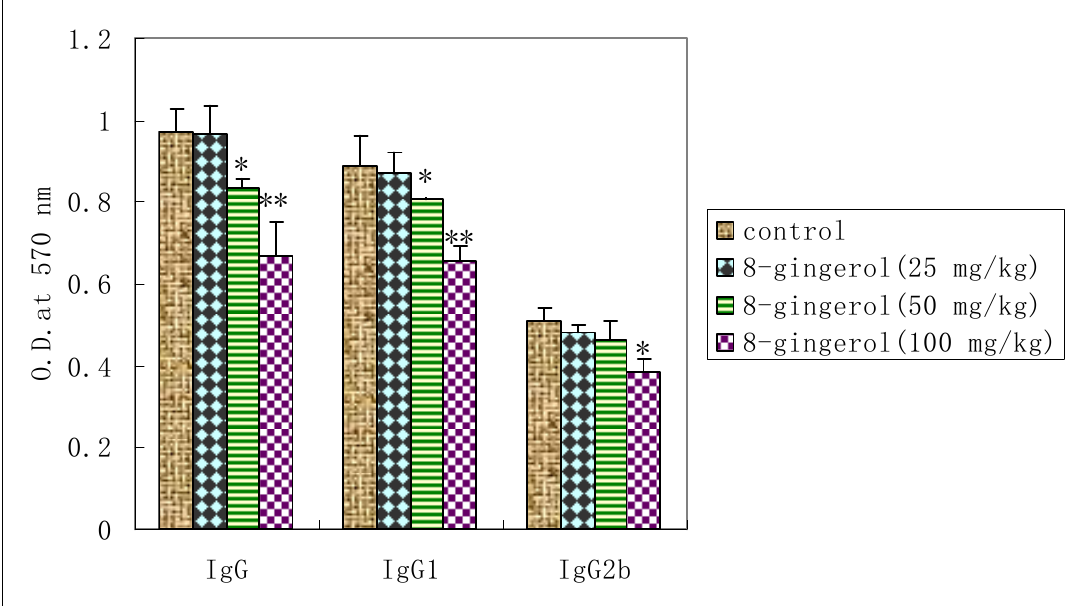
Figure 5. Effect of 8-gingerol on the OVA-speci fi c serum antibody